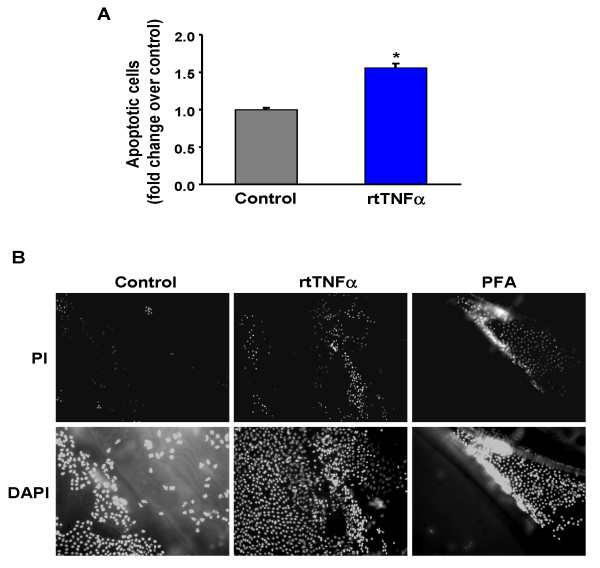
Effects of rtTNFα treatment in vitro on apoptosis and cell viability in brown trout preovulatory follicles. A. To determine the incidence of apoptosis, granulosa cells isolated from trout preovulatory follicles incubated in the absence or presence of rtTNFα (100 ng/ml) were stained with propidium iodide (PI) and analyzed by flow cytometry (FACS analysis). Each bar represents the mean ± SE of six independent experiments, each performed with ovarian tissue from a different female (n = 6). The results are expressed with respect to the control group which has been set at 1. Statistically significant (p < 0.05) differences with respect to the control group are indicated by an asterisk (*). B. Granulosa cell viability was assessed by incubating brown trout preovulatory follicles in the absence or presence of 100 ng/ml rtTNFα, or 1% paraformaldehyde (PFA) as a positive control, for 18 h at 15°C, separating the granulosa layers and staining them with PI. Subsequently, sheets of granulosa layers were mounted onto glass slides, counterstained with DAPI and visualized under a fluorescent microscope.